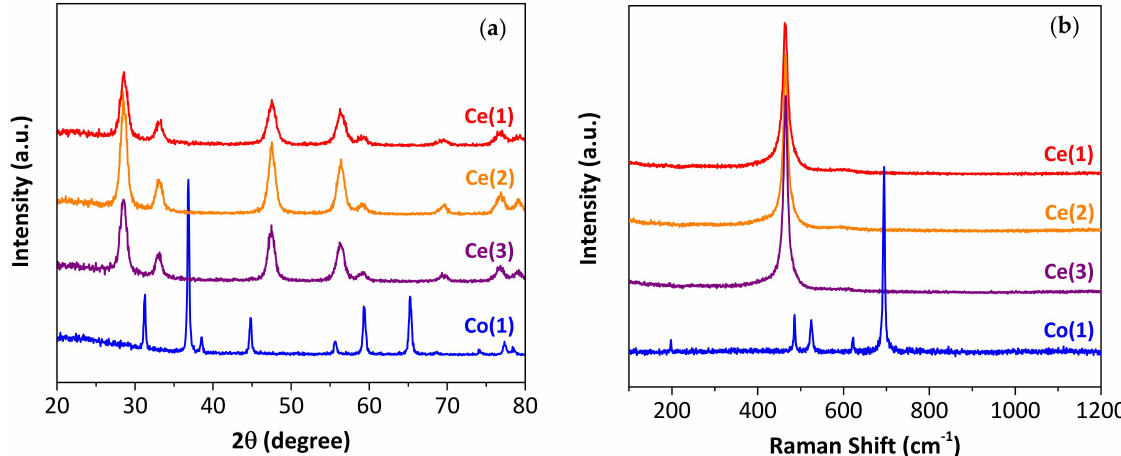
Figure 2. XRD patterns ( a ) and Raman spectra ( b ) of synthesized